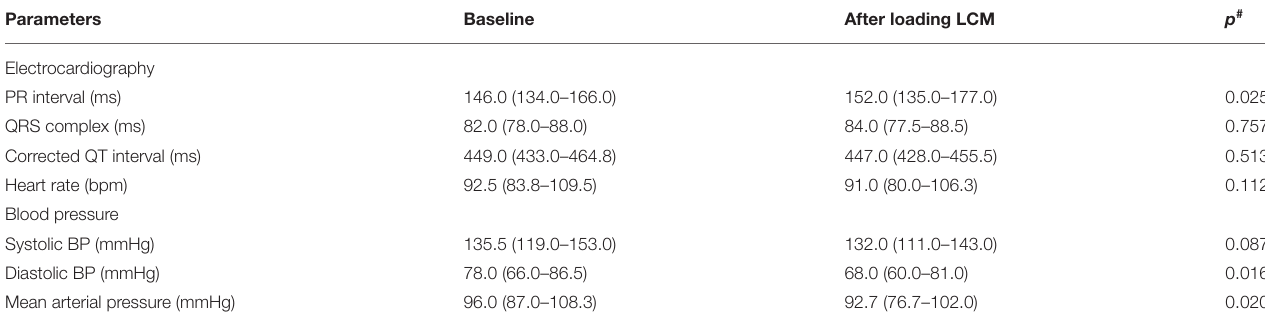
TABLE 4 | The change of cardiac parameters after lacosamide use. Parameters